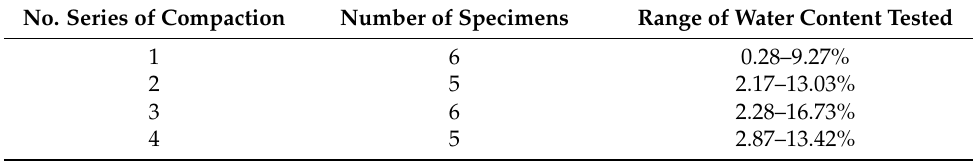
Table 4. Series of compaction tested, number of specimens and range of moisture content. No. Series of